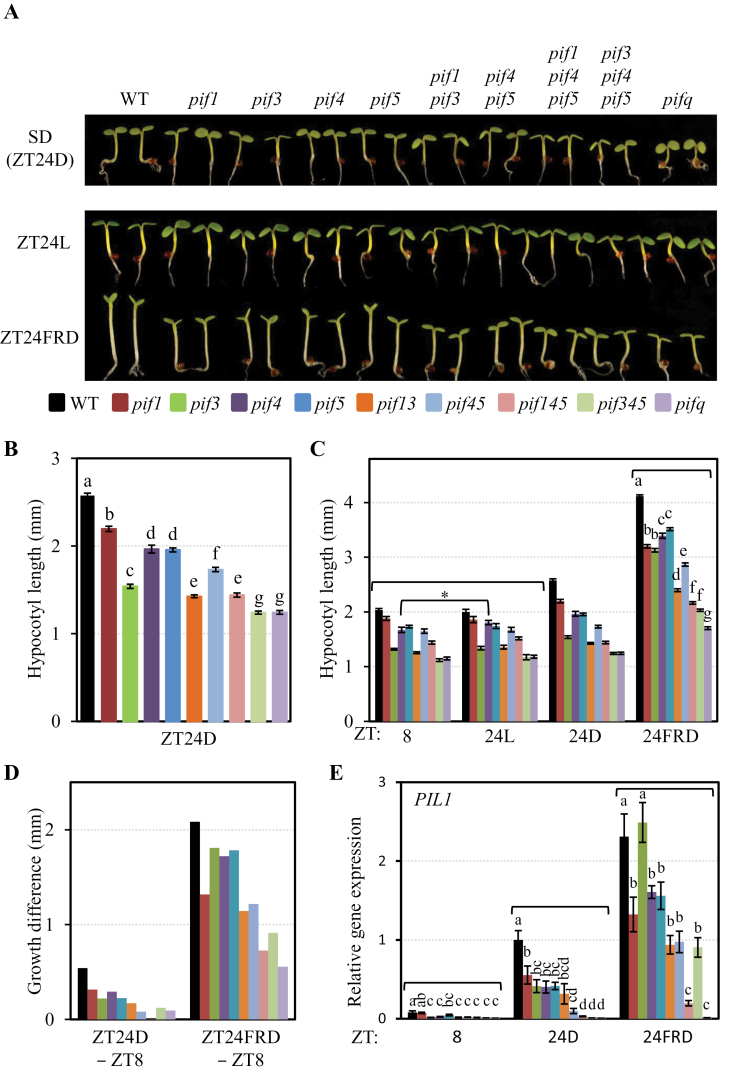
Morphological and gene expression analysis of pif1 and higher order pif mutant combinations under SD conditions provides evidence for differential contributions of individual PIF quartet members. (A) Visible phenotypes of WT, pif1, pif3, pif1pif3, pif4pif5, pif1pif4pif5, pif3pif4pif5, and pifq mutant seedlings grown for 3 d in SD conditions (ZT24D) (top), or in ZT24L and ZT24FRD as specified in Fig. 1A and 2A, respectively (bottom). (B) Quantification of the hypocotyl elongation of 3-day-old SD-grown (ZT24D) WT and pif-mutant seedlings shown in A (top). Data represent the mean and SE of at least 20 seedlings. Different letters indicate signiﬁcant differences among means (P-value <0.05). (C) Quantification of the hypocotyl elongation of 3-day-old ZT24FRD- and ZT24L-grown WT and pif-mutant seedlings shown in A (bottom), compared with SD-grown (ZT24D) seedlings and seedlings grown under SD conditions for 2 d and 8h (ZT8). Data represent the mean and SE of at least 20 seedlings. For ZT24FRD, different letters denote significant differences among means (P < 0.05). In the case of ZT8 and ZT24L, the genotypes that show a statistical difference in ZT24L compared with ZT8 are indicated with an asterisk. (D) Differential growth responsiveness during the night period was calculated from data shown in C. Mean hypocotyl length at ZT8 was subtracted from the mean hypocotyl length at ZT24D or ZT24FRD for each genotype. The growth difference of pif1pif4pif5 in ZT24D was nearly zero. (E) PIL1 gene expression in WT, and pif1, pif3, pif1pif3, pif4, pif5, pif4pif5, pif3pif4pif5, and pifq mutant seedlings grown under SD conditions for 2 d and 8h (ZT8), 3 d (ZT24D), or under ZT24FRD conditions as specified in Fig. 2A. Different letters denote significant differences among means (P < 0.05). Most mutant combinations at ZT8, pif1pif4pif5, pif3pif4pif5, and pifq at ZT24D, and pifq at ZT24FRD had expression levels near zero.